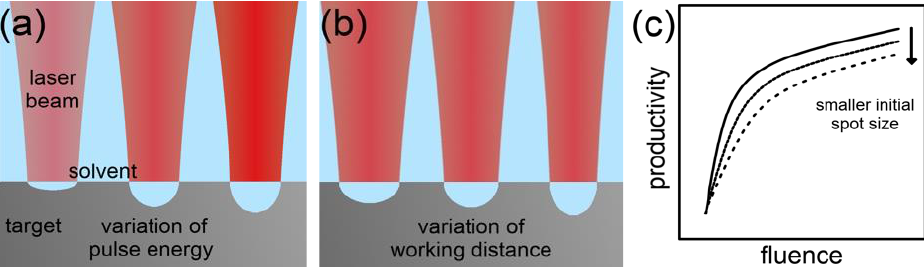
Figure 7. Illustration of the laser ablation of metals in liquids at different fluences varied by the pulse energy ( a ) and the working distance ( b ). The diagram in ( c ) demonstrates how the fluence variation caused by different initial spot sizes affects the NP productivity in LAL in the high-fluence regime. A Gaussian beam profile was assumed. In ( c ), both axes scale linearly. The trends shown in the diagram represent the interpretation of the combined results of the discussed literature in Section 2.2.1. The arrow and the less dense (dashed) line style in ( c ) indicate the trend in productivity induced by a smaller initial spot size. Reprinted with permission from [66].